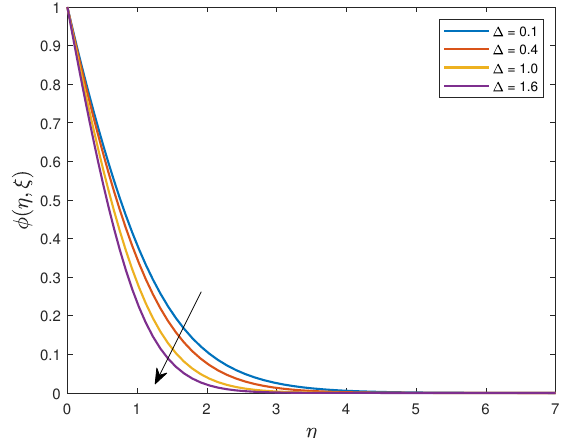
Figure 32. The influence of ∆ on fluid temperature.